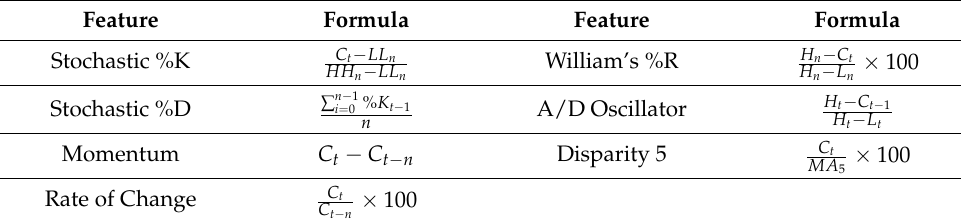
Table 9. Stock indicator formulas.